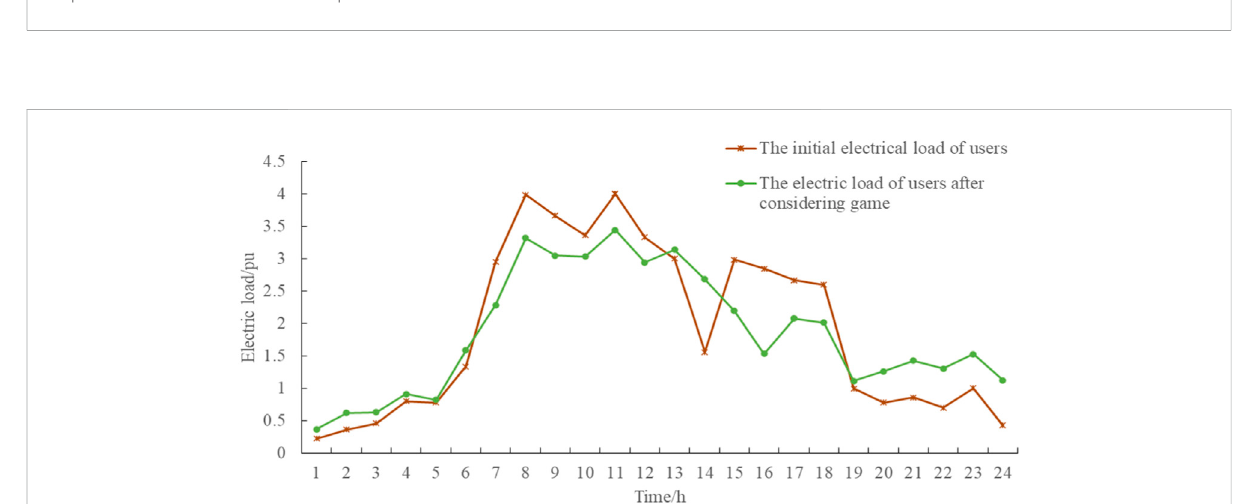
FIGURE 6 Optimization results of thermal output.